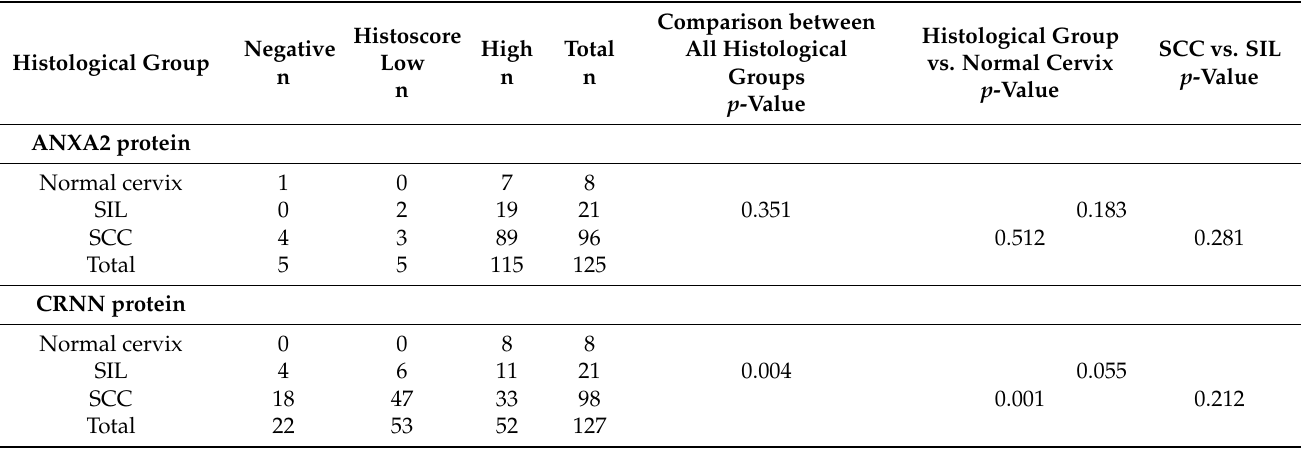
Table 6. The association between ANXA2 and CRNN proteins expression with subject’s age, SIL grade, and SCC stage.